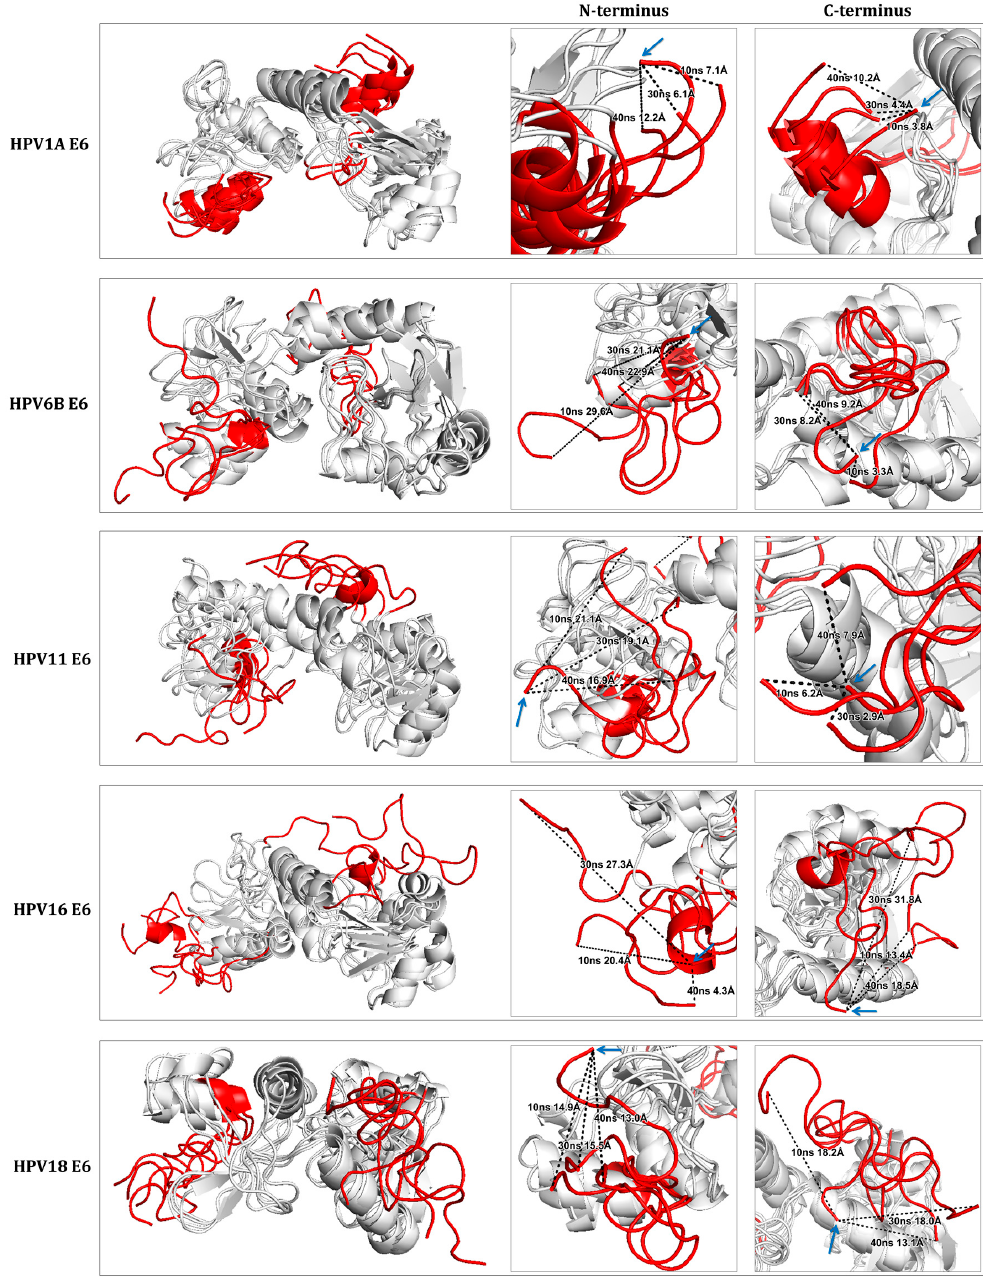
Figure 5. Comparison between the different structural conformations of E6 proteins from HPV16, HPV18, HPV6B, HPV11, and HPV1A by molecular dynamics simulation. The N- and C-termini of the structures are highlighted in red and the central region between the terminals is shown in gray. The panels, next to the aligned structures, highlight the two termini with the black dotted lines showing the distance of the variation of the same amino acids at times 0 (indicated by the blue arrow), 10, 30, and 40 ns. It is observed that the structural variation occurs mainly in the terminal regions of all the structures. Distances were measured using PyMOL 2.0 software [27]. Dotted line: the distance of the variation of the same amino